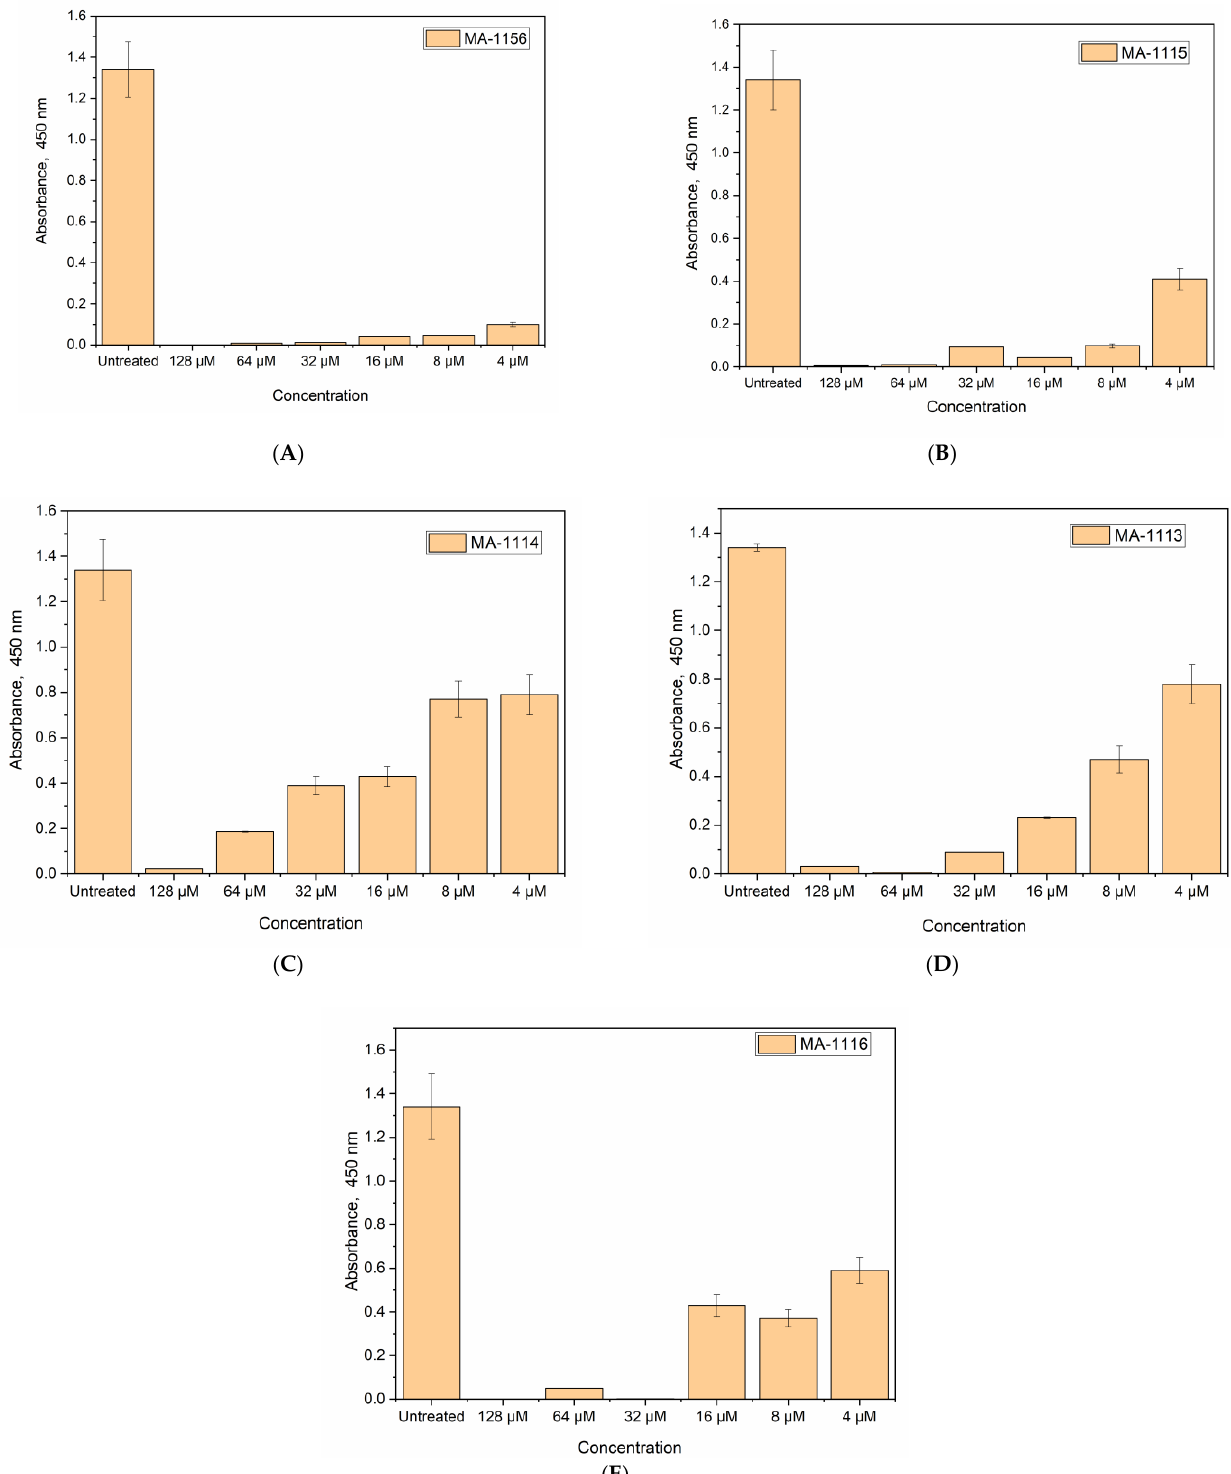
Figure 6. Testing the cell viability of S. aureus treated with the tested fluoroarylbichalcophenes at different concentrations (0–128 µM) using the WST1-test ( A ) compound MA-1156 ; ( B ) compound MA-1115 ; ( C ) compound MA-1116 ; ( D ) compound MA-1113 ; ( E ) compound MA-1114 .